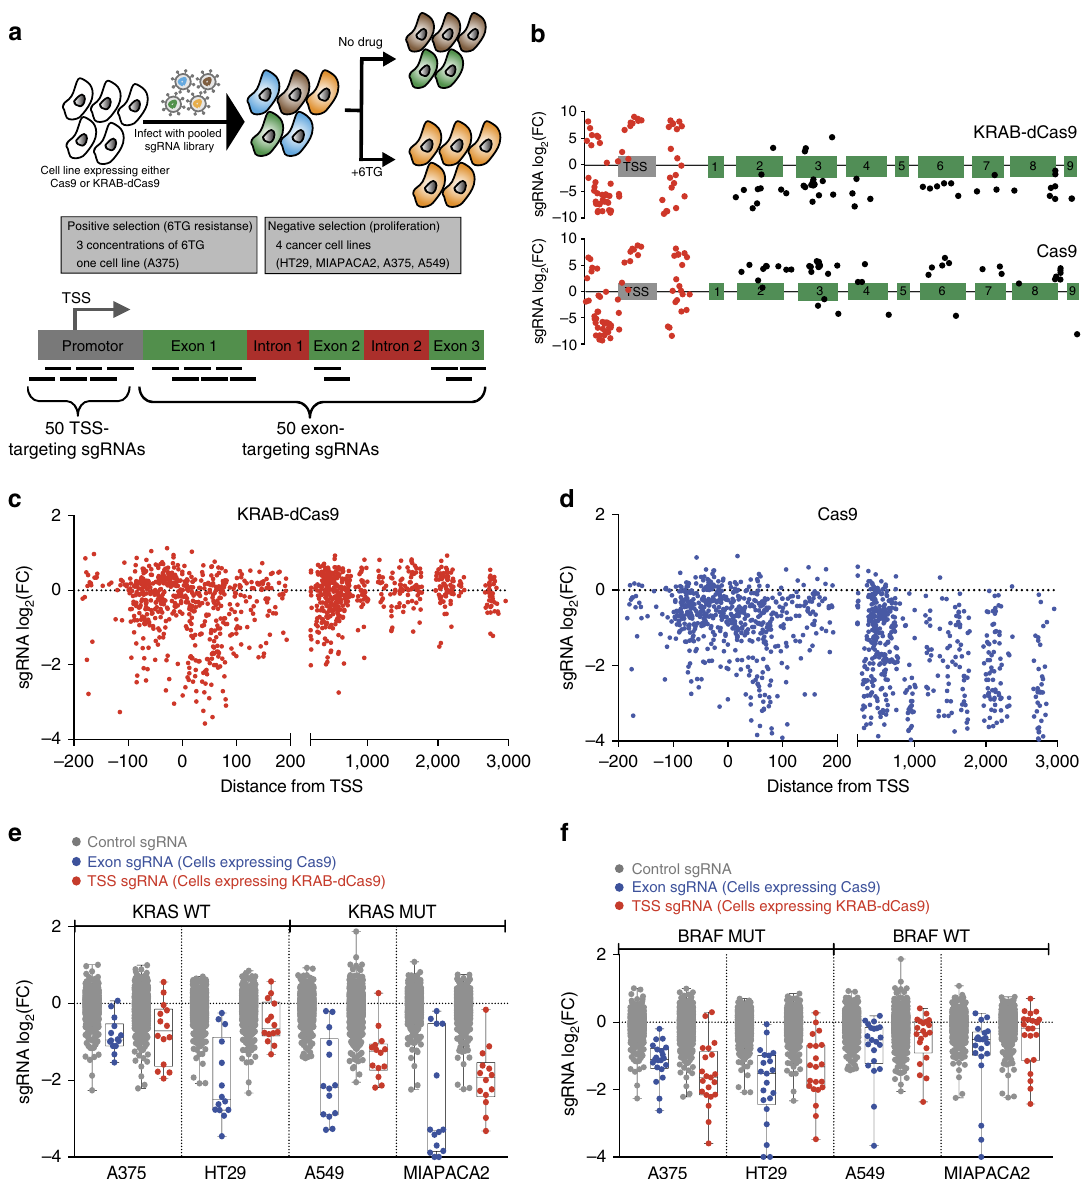
Figure 1 | Loss-of-function screens performed in cells expressing Cas9 and KRAB-dCas9 using tiling sgRNA library. ( a ) Strategy used for design and assessment of the tiling sgRNA library. ( b ) Proliferation changes fold-change (FC) induced by sgRNAs-targeting HPRT1 following treatment of A375 cells with 6TG (15 m M) in cells expressing either Cas9 or KRAB-dCas9. ( c ) Proliferation changes induced by sgRNAs targeting seven cell essential genes ( POLR1C , POLR2D , RPL19 , RPL4 , RPL5 , RPL8 , U2AF1 ) in KRAB-dCas9-expressing cells. Each point represents the mean sgRNA score across four cell lines. ( d ) Cells expressing Cas9 and the sgRNAs from c . ( e ) Proliferation changes induced by control or KRAS -targeting sgRNAs in cells expressing KRAB-dCas9 (red) or Cas9 (blue). Only efficient sgRNAs (as determined by the sgRNA predictive algorithm) are shown for KRAB-dCas9 and only exon-targeting sgRNAs are shown for Cas9. ( f ) Proliferation changes induced by control or BRAF -targeting sgRNAs. Error bars represent the deviation from the mean of sgRNAs targeting the indicated genes. All FCs are presented as the mean of duplicate